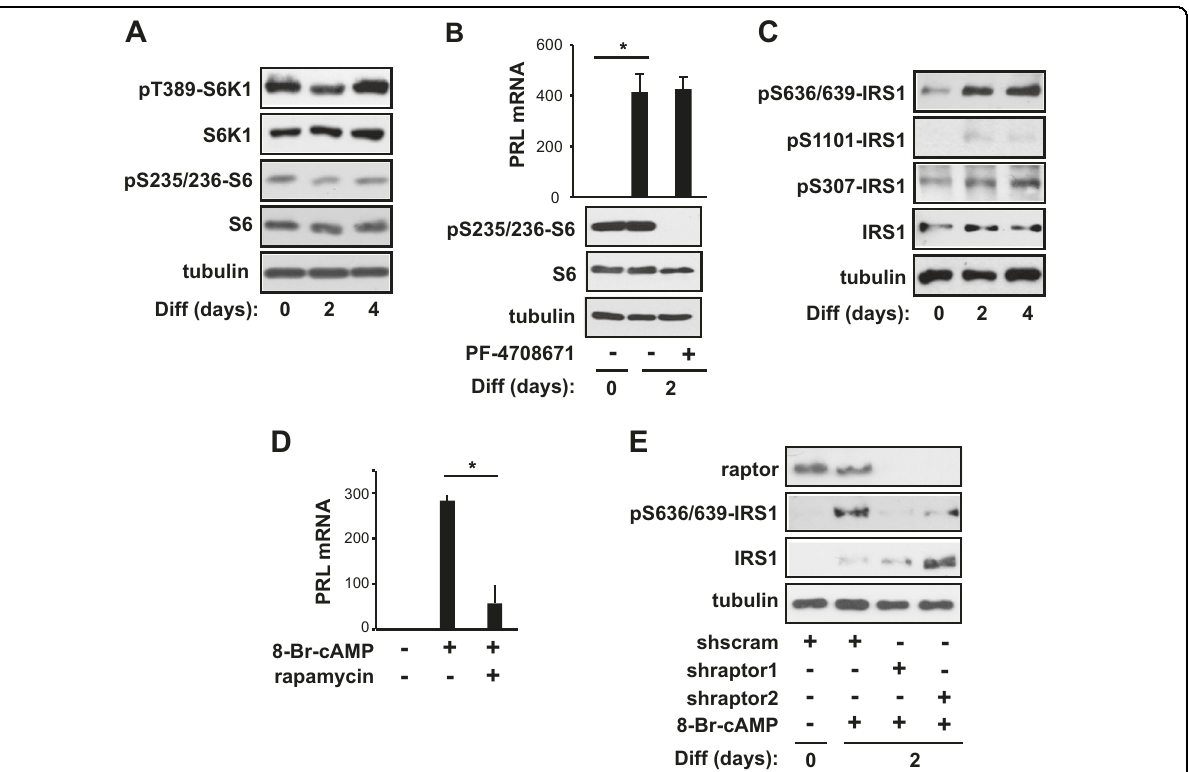
Fig. 2 mTORC1 phosphorylates IRS-1 at S636/639 during 8-Br-cAMP-induced decidualization. a Human endometrial stromal (hES) cells were induced to differentiate for 4 days in the presence of 0.5 mM 8-Br-cAMP. On day 0, 2, or 4 of differentiation, the cells were lysed and subjected to western blotting. b Cells were differentiated with or without 15 μ M PF-4708671 at the initiation of differentiation for 2 days. Cells were lysed and then analyzed by either quantitative RT-PCR or western blotting. c On day 0, 2, or 4 of differentiation, the cells were lysed and subjected to western blotting. d Cells were differentiated for 2 days with or without 100 nM rapamycin at the initiation of differentiation for 2 days. e hES cells were infected with lentiviruses expressing two different raptor shRNAs or scrambled shRNA; cells were then selected by puromycin for 5 days. After 2 days of differentiation, the cells were lysed and then analyzed by either quantitative RT-PCR or western blotting. Human GAPDH was used to normalize gene expression. All blots are representative of three to fi ve independent experiments. All data are shown as the mean ± SD, with paired t -tests performed as indicated. * P <